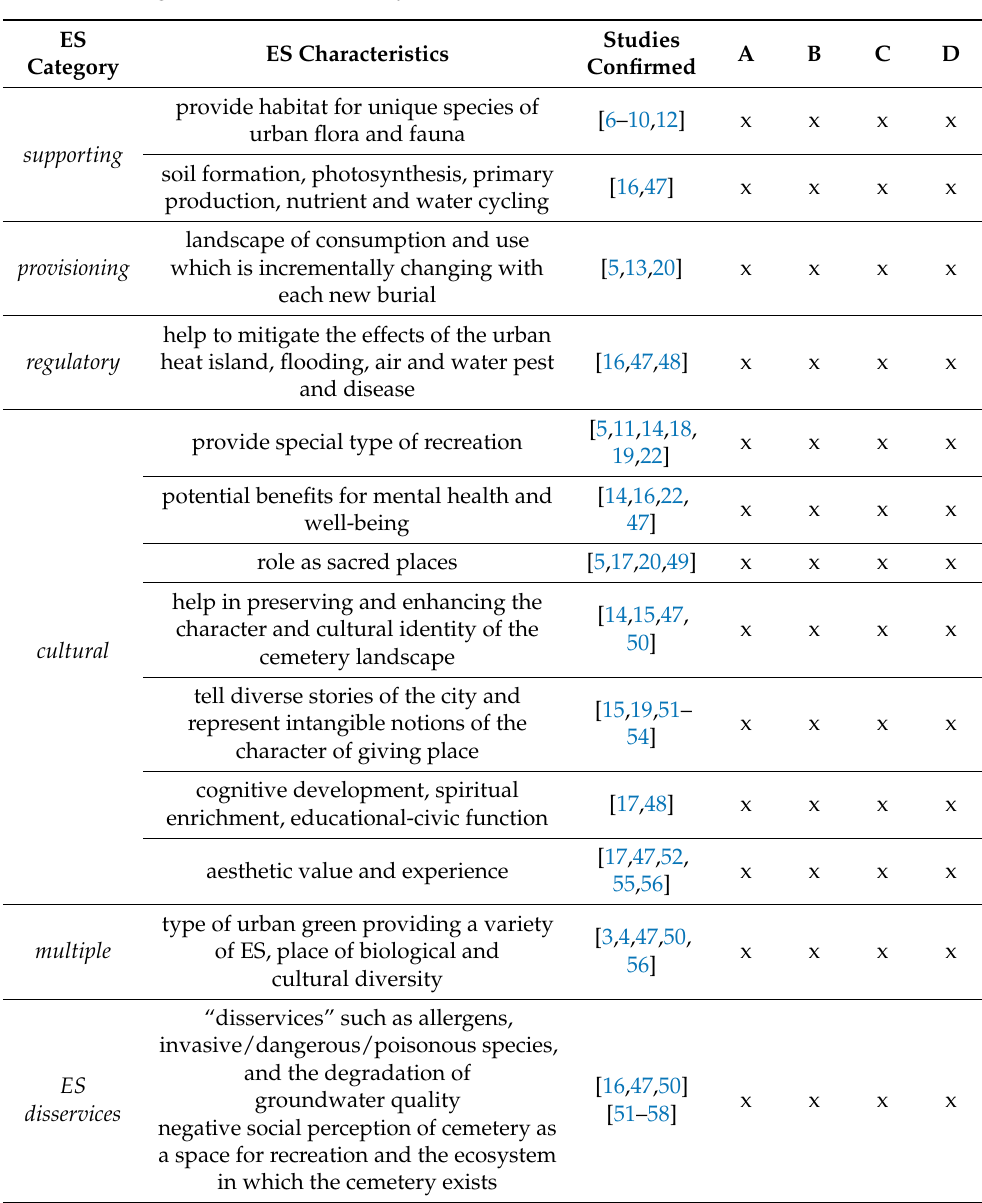
Table 1. Characteristics of ES provided by selected cemeteries in Leipzig and Ł ó d´z considering the results of a literature review on the respective ES of cemeteries. Legend: A—Old Jewish Cemetery